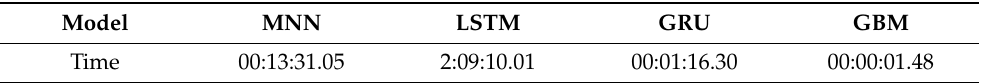
Table 11. The SOC estimation times for MNN, RNN, GRU, and GBM.